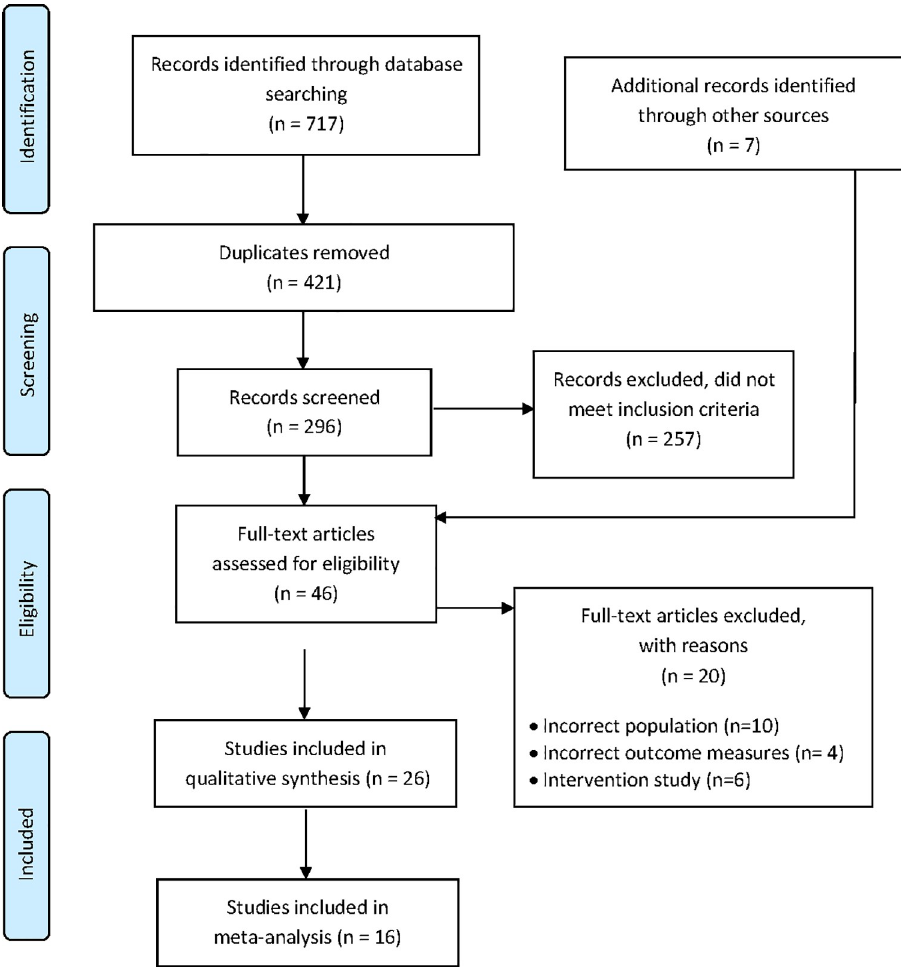
Fig 2. PRISMA flow